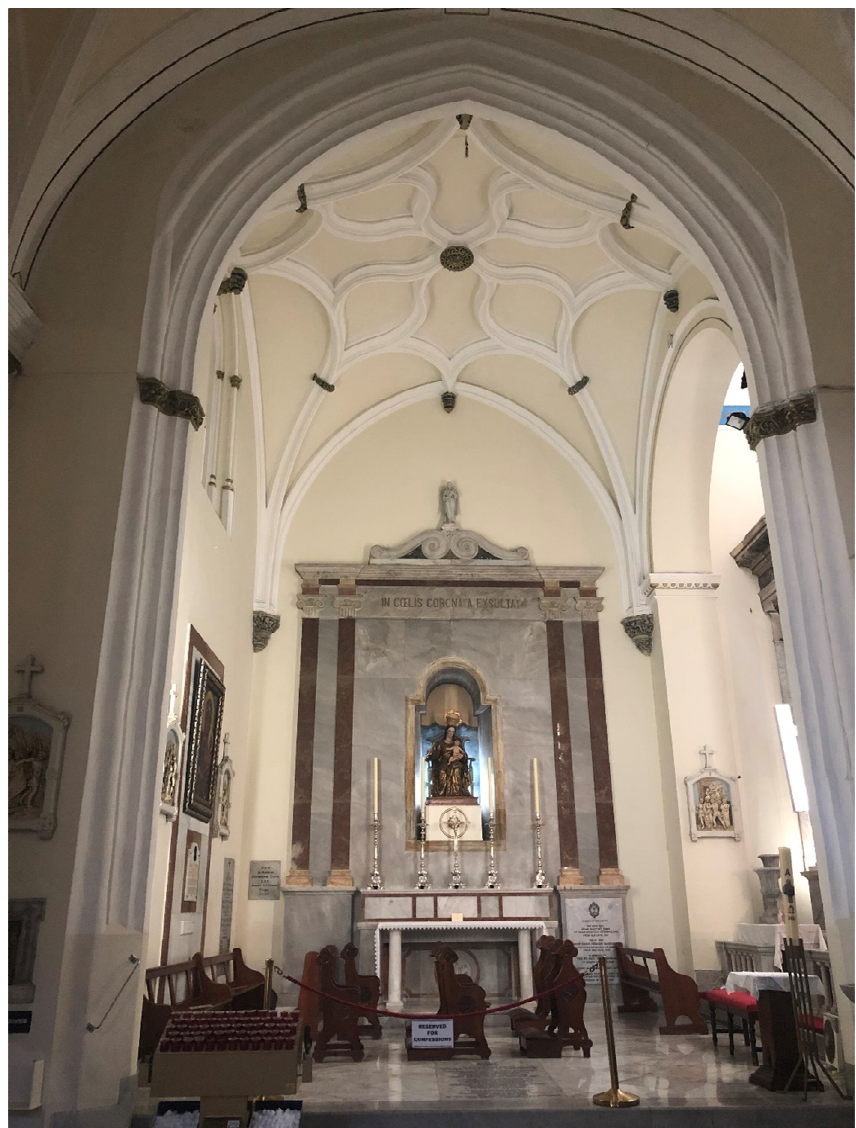
Figure 13. The Sanabria Chapel in the Cathedral of Saint Mary the Crowned.